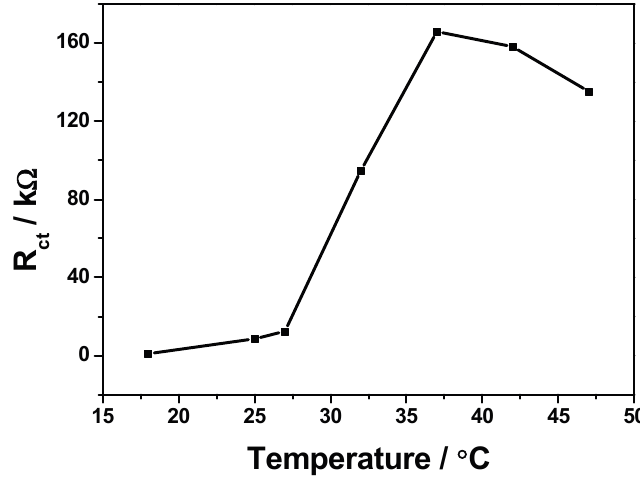
Figure 3. Effect of temperature